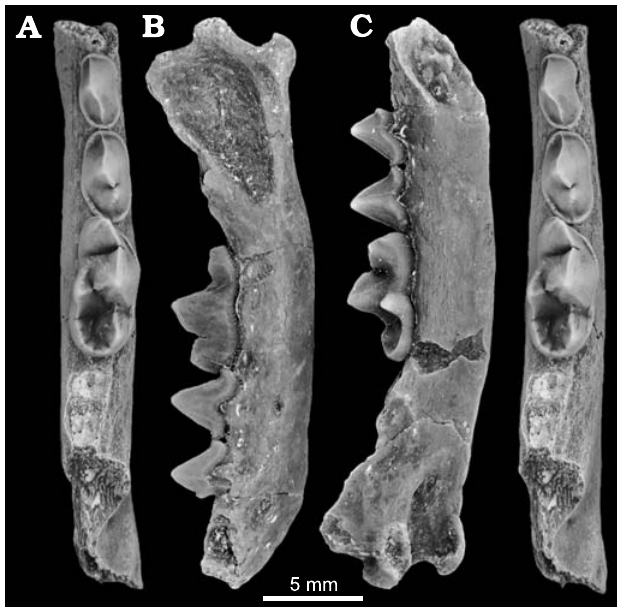
Fig. 6. Mustelid carnivoran Brevimalictis chikasha gen. et sp. nov. from the Eastgate LF, basal-most unit of the Monarch Mill Formation, Barstovian (Miocene), Churchill County, Nevada, USA. UCMP 113319, holotype right dentary with p3–m1 in occlusal ( A , stereopair), labial ( B ), and lingual ( C )